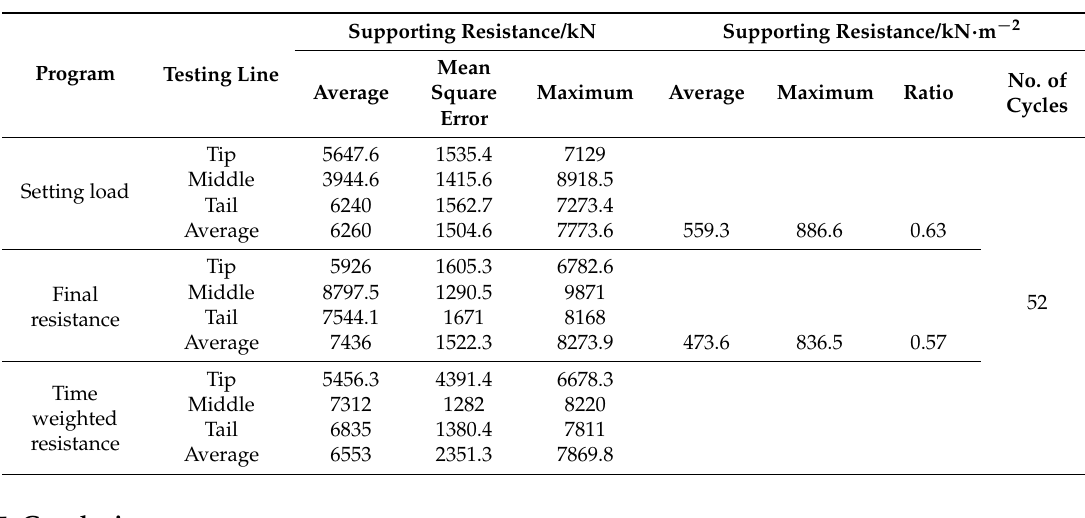
Table 5. Supporting strength of the